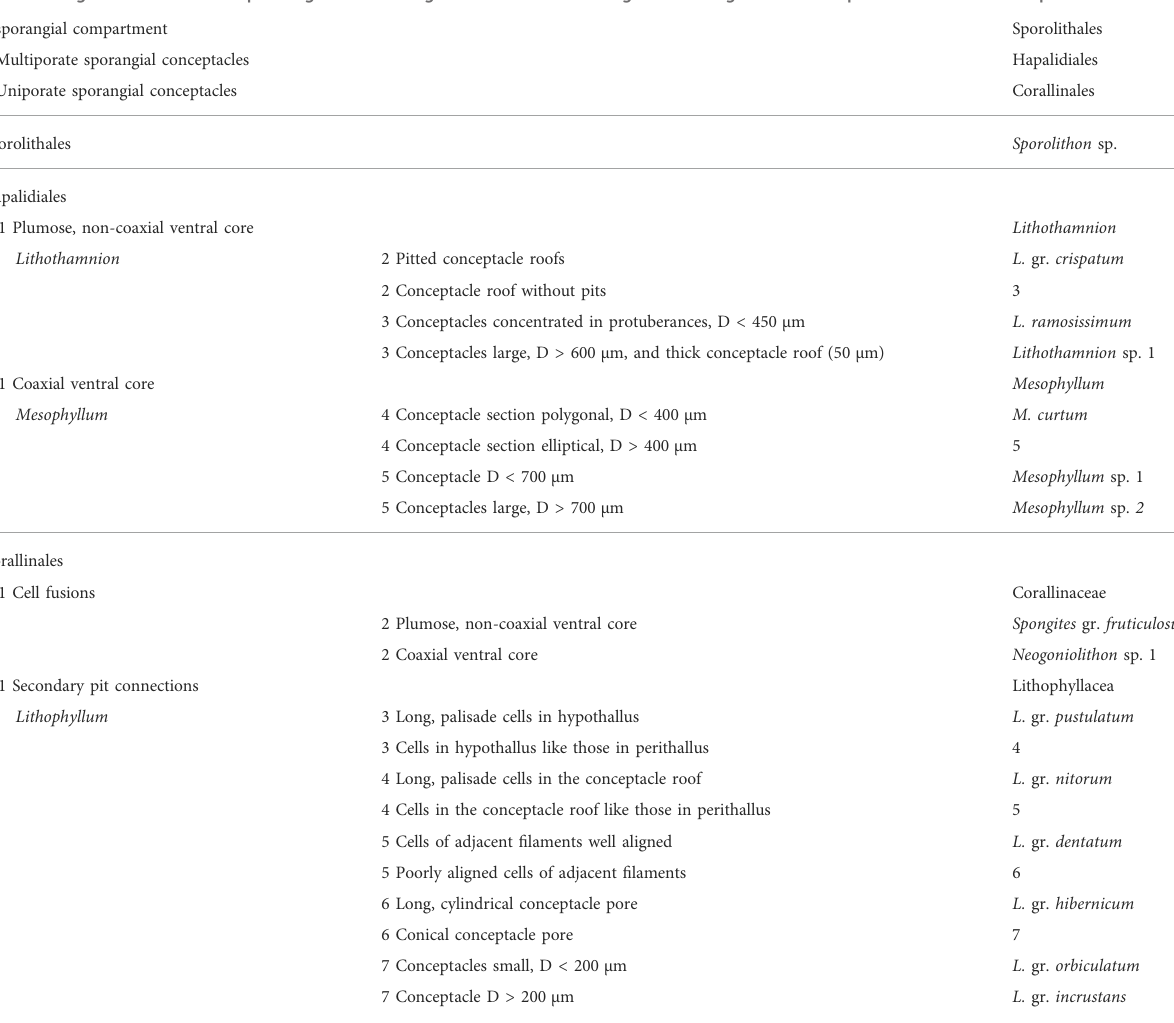
TABLE 1 Diagnostic characters separating the taxa recognized in the coralline algal assemblages in the Acinipo limestone. D= conceptacle diameter.